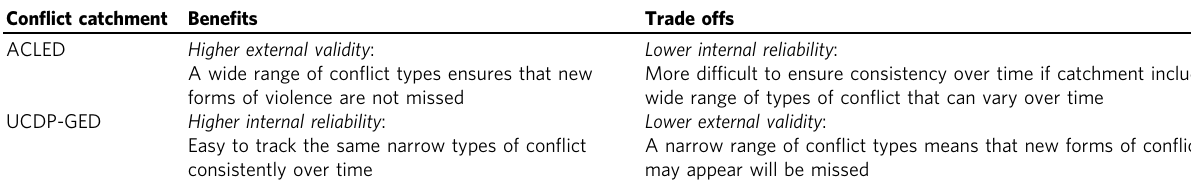
Table 2 Researcher-led datasets ’ con fl ict catchment strategies and their bene fi ts and tradeoffs. Con fl ict catchment Bene fi ts Trade offs Lower internal reliability : ACLED Higher external validity : More dif fi cult to ensure consistency over time if catchment includes a A wide range of con fl ict types ensures that new wide range of types of con fl ict that can vary over time forms of violence are not missed UCDP-GED Higher internal reliability : Easy to track the same narrow types of con fl